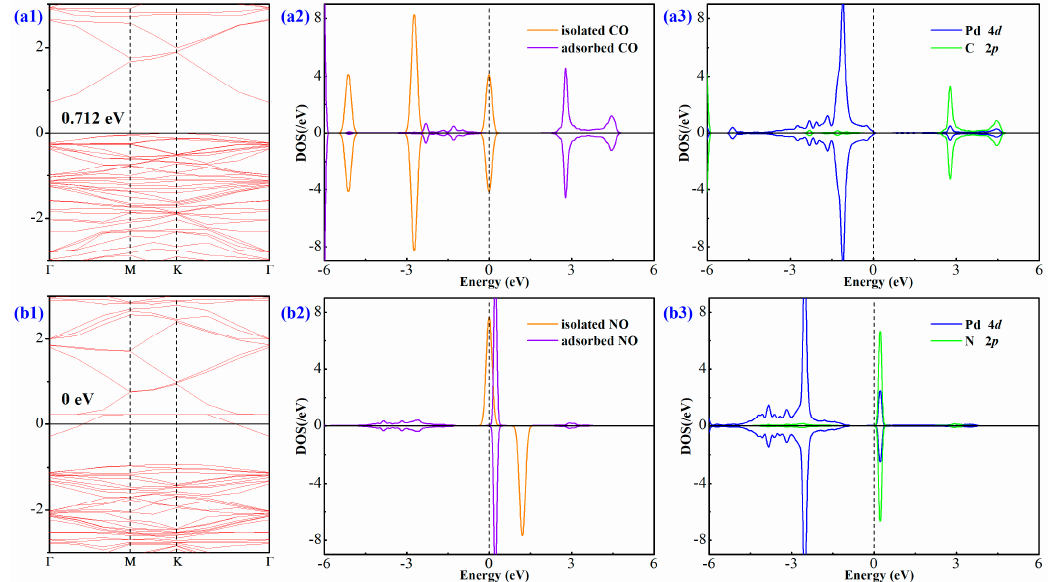
Figure 5. Band structures and DOS distributions of adsorbing systems. ( a1 – a3 ) CO system; ( b1 – b3 ) NO system. The figures from left to right successively represent band structures of gas adsorption systems, the molecular DOS of target gases, and the atomic DOS of bonded atoms. The dash line is the Fermi level.